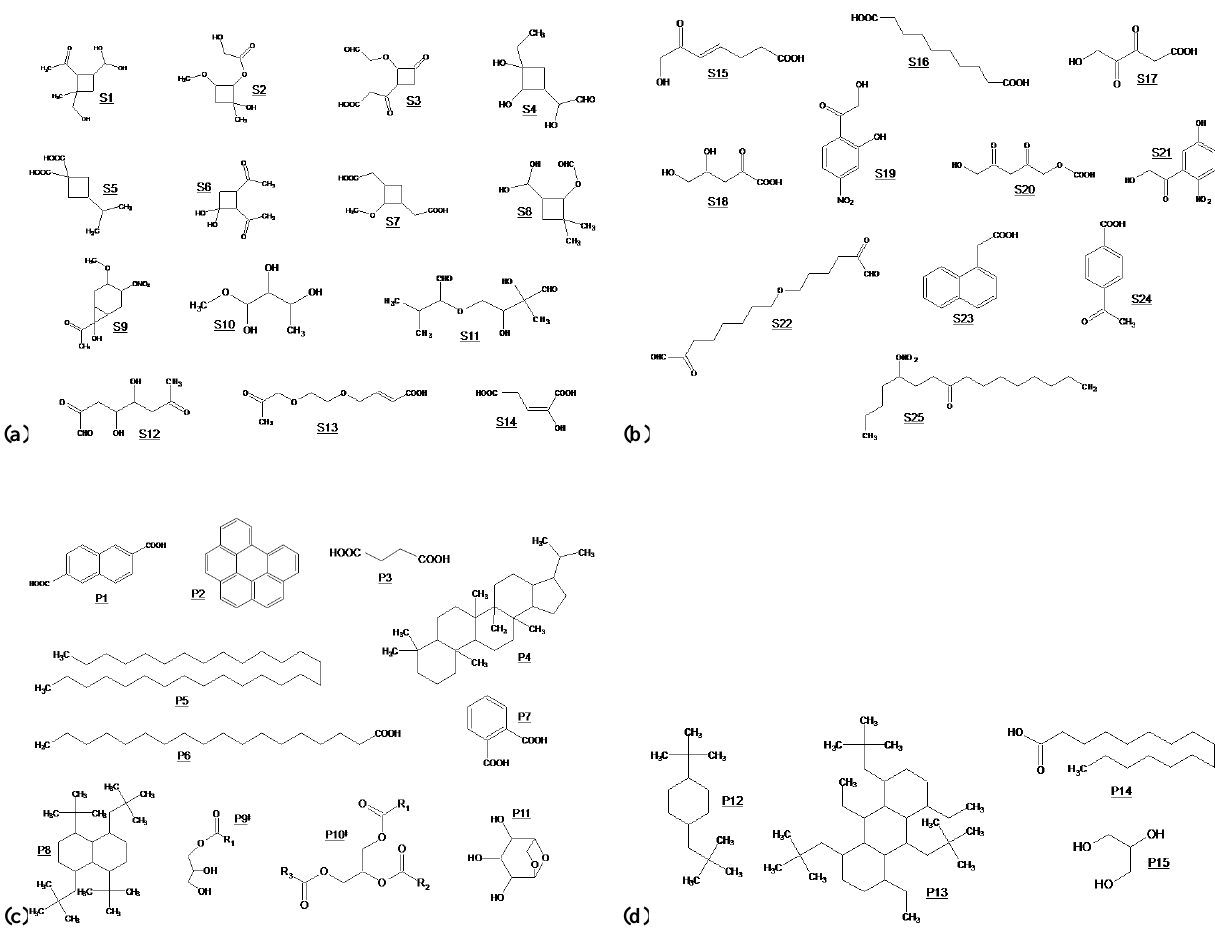
Fig. 1. Molecular structures of lumped SOA products and surrogate POA compounds. ‡ R 1 =C 15 alkyl chain; R 2 =C 17 alkyl chain; R 3 =C 17 alkyl chain with one double bond. For some structures, ether linkages have been included to fine tune the estimated polarity, even when such linkages may be unlikely consequences of the relevant oxidation